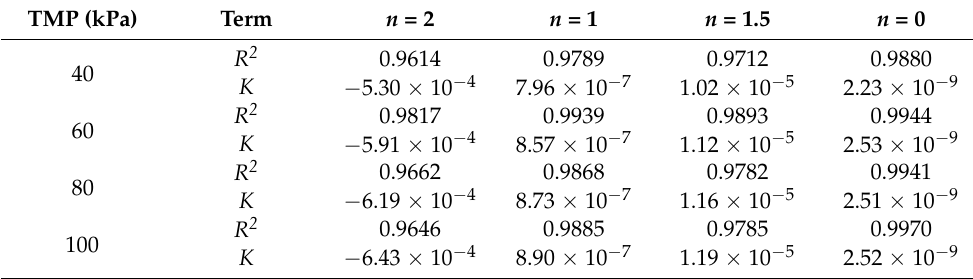
Table 5. R 2 values and K constants in the Hermia model at different TMPs. TMP (kPa)